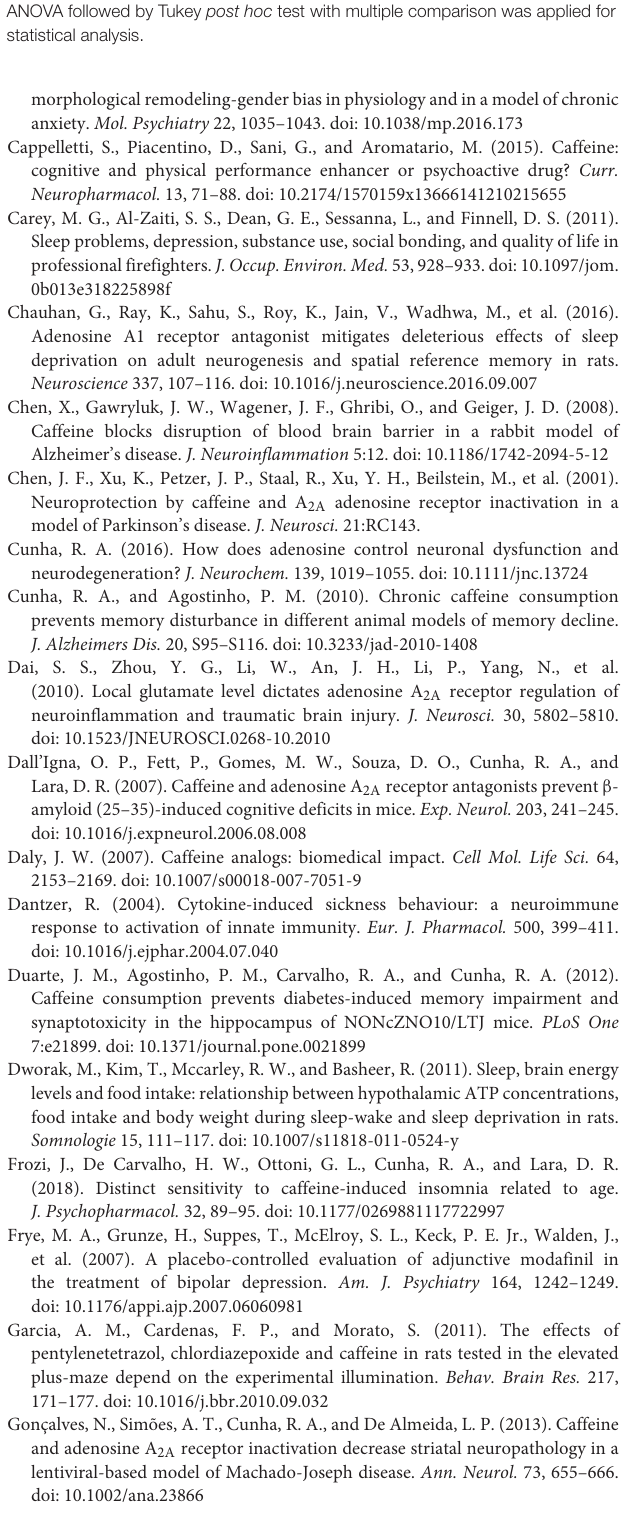
FIGURE S1 | Caffeine or modafinil treatment improved the sleep deprivation (SD)-induced physiological changes in rats. Changes in (A) body weight; (B) food intake. ∗ p < 0.05 when compared to control treated with vehicle; φ p < 0.05, when compared to sleep deprived treated with vehicle. Two way ANOVA followed by Tukey post hoc test with multiple comparison was applied for statistical comparison between groups and for the graphical representation, values expressed mean percentage of Control ± SEM.